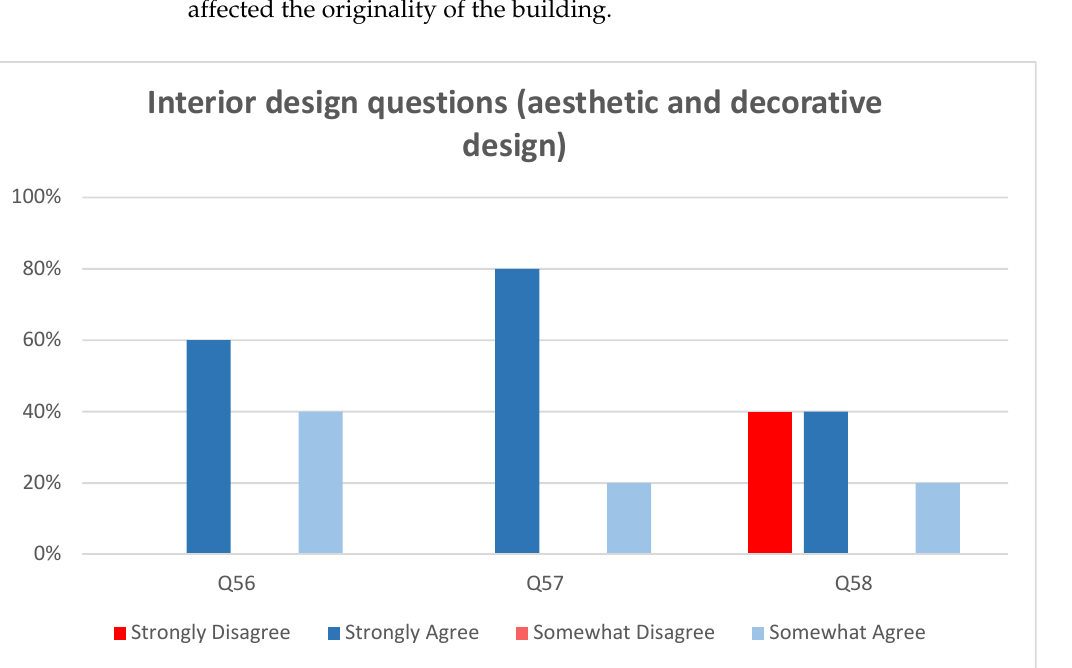
Table 11. Interior design questions (aesthetic and decorative design) .